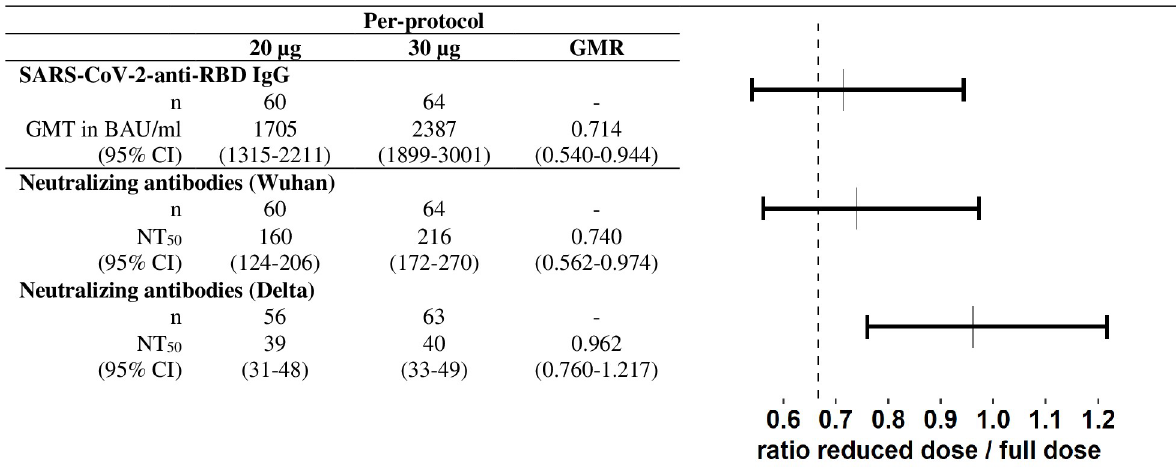
Fig 2. Immune responses by study arm at 28 days post second vaccine dose (Day 49) and non-inferiority analysis in the per-protocol cohort. Data are geometric mean titres (95% CI) at day 28 post second dose. GMRs (95% CI) were adjusted with a linear mixed-effect model including gender, age and SARS-CoV-2 anti-RBD IgG titre at baseline as fixed variables and location as random variable. In the figure, the dashed line indicates the WHO recommended non-inferiority margin of 0.67. GMT = geometric mean titre. GMR = geometric mean ratio. BAU = Binding antibody units. NT50 = 50% neutralizing antibody